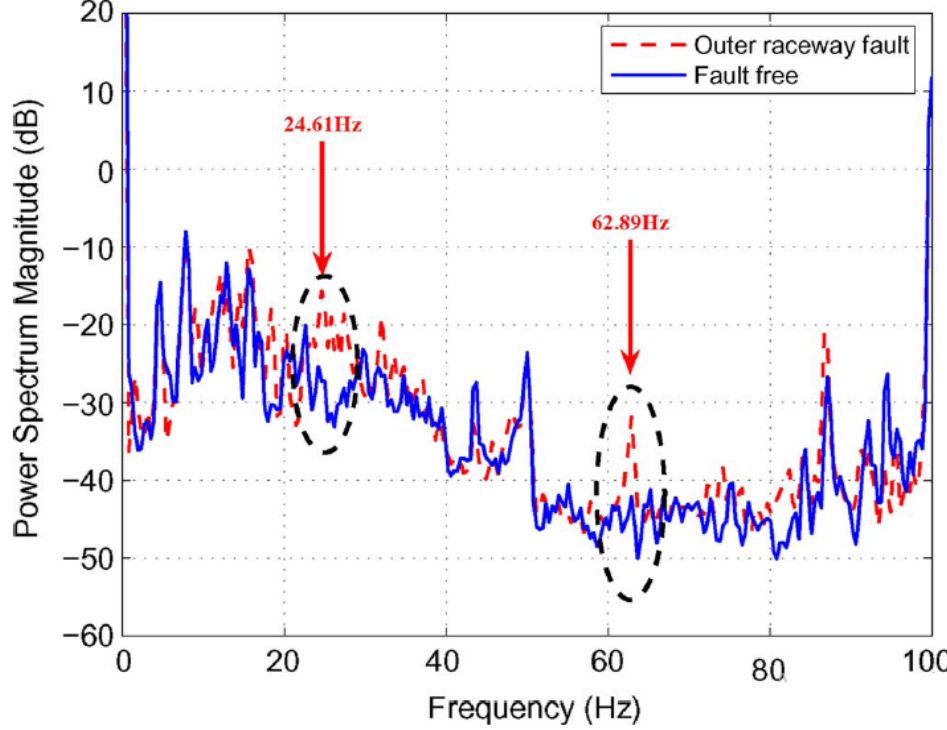
Figure 12. Power spectrum density based on frequency spectrum for diagnostics of bearing healthy condition and outer raceway fault [35].